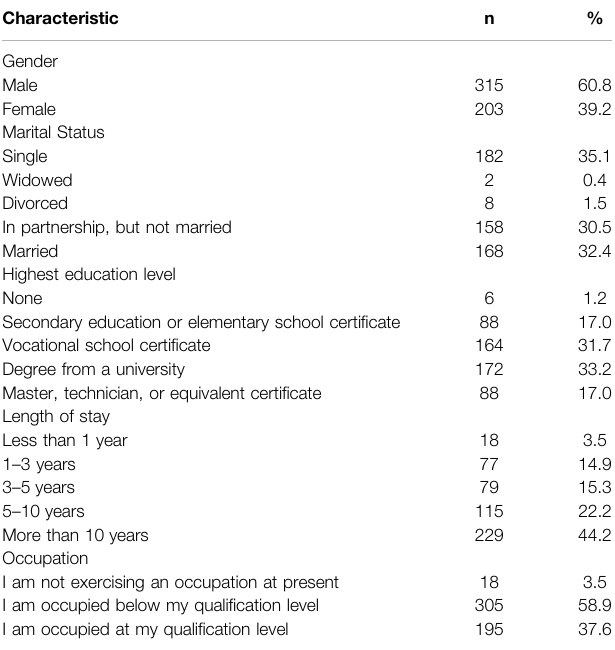
TABLE 1 | Socioeconomic and demographic characteristics of participants ( N (cid:1) 518). Characteristic